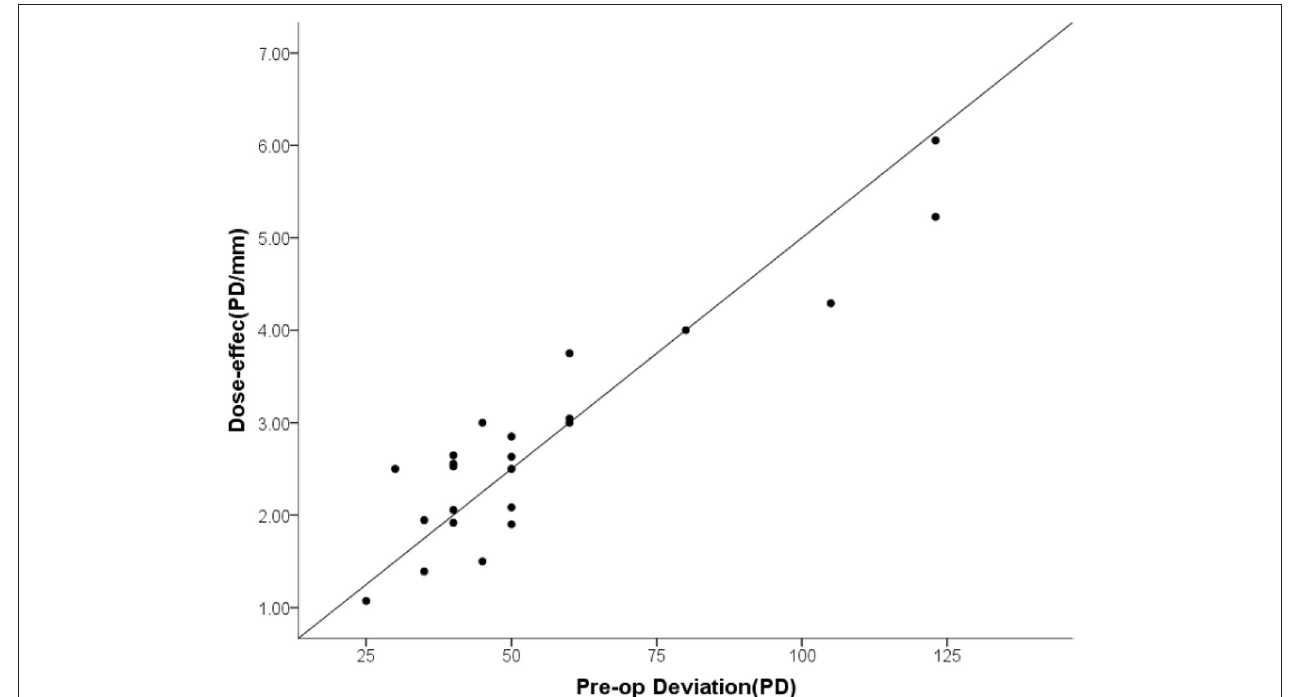
FIGURE 2 | The dose-effect coefficient was linearly related to the pre-operative esodeviation.